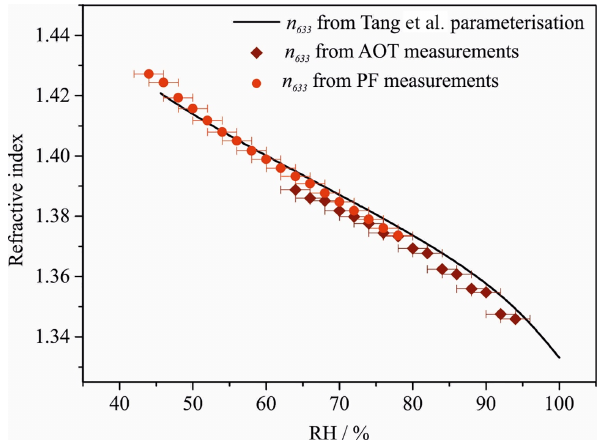
Figure 3. Comparison of the RH-dependant parameterisation of n 633 reported by Tang et al. (1997) and Tang and Munkel- witz (1994) for aqueous NaCl to n 633 measured from 633nm Gaussian-illuminated PFs and Raman spectroscopy from aerosol optical tweezer measurements. The error bars correspond to uncer- tainties associated with RH measurements. Figure 4. Representative SP-CRDS measurements of σ ext (red points) and best-fit CSW Mie envelopes (black lines) for aqueous aerosol particles containing the inorganic solutes NaCl, NaNO 3 , and (NH 4 ) 2 SO 4 . The measured σ ext values were collected using either 405nm (left column) or 532nm (right column)